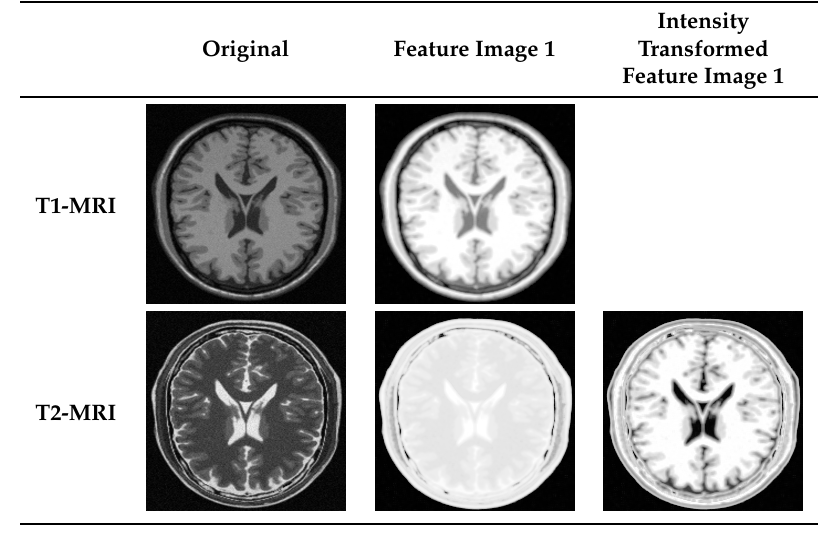
Figure 8. Transforming multi-modal scans into a same intensity coordinate system. Even though original T1- and T2-MRI have intensity variations, T2- intensity transformed feature image uses comparable relative intensity levels as T1-MRI feature image to generate the necessary contrast in the